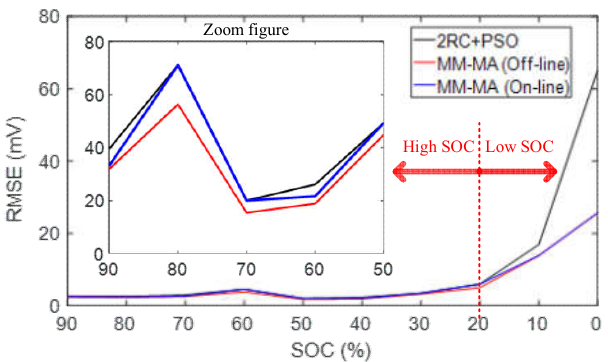
Figure 8. Identification results of the multi-model and multi-algorithm combination (MM-MA) method.